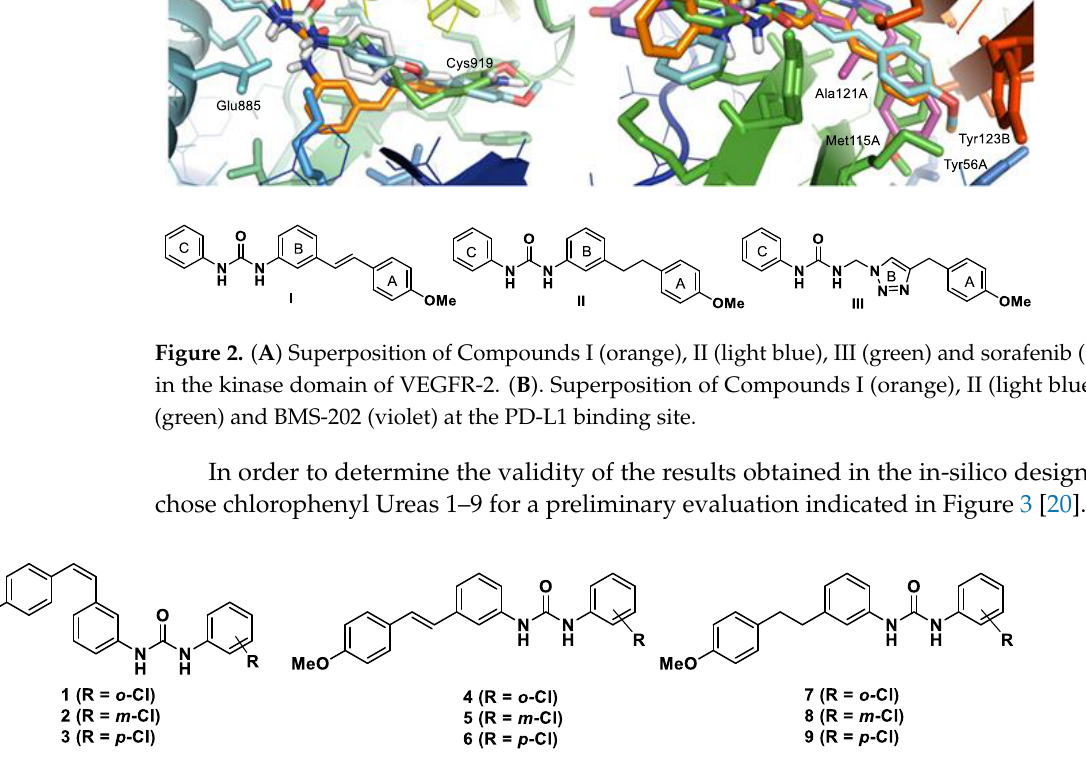
Figure 3. Potential multitarget inhibitors of VEFGR-2 and PD-L1.